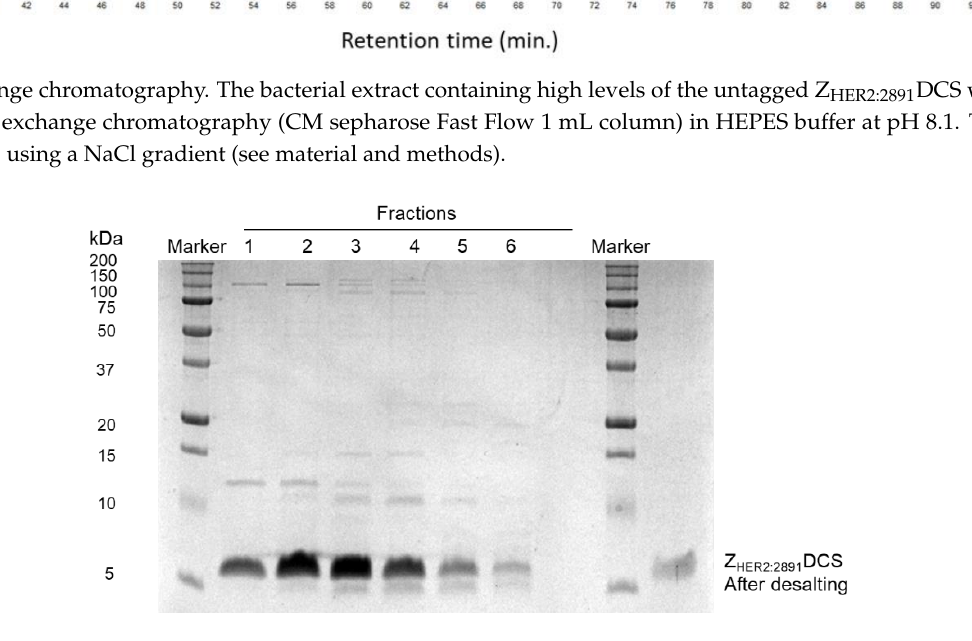
Figure 3. Fraction analysis on SDS-PAGE gel and desalting. All the fractions collected were analyzed on 15% SDS-PAGE gel. The fractions contained the untagged Z HER2:2891 were pooled together